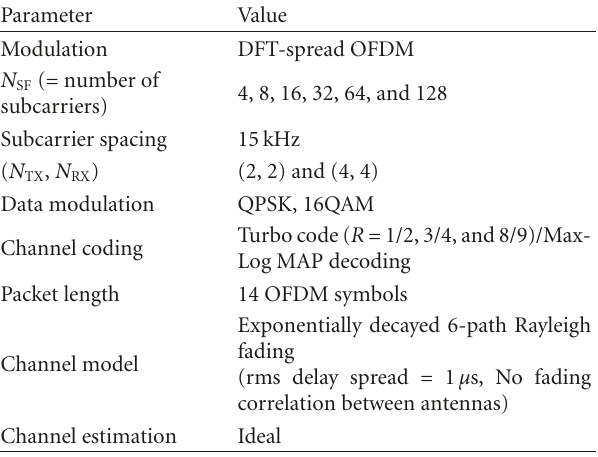
Table 1: Simulation